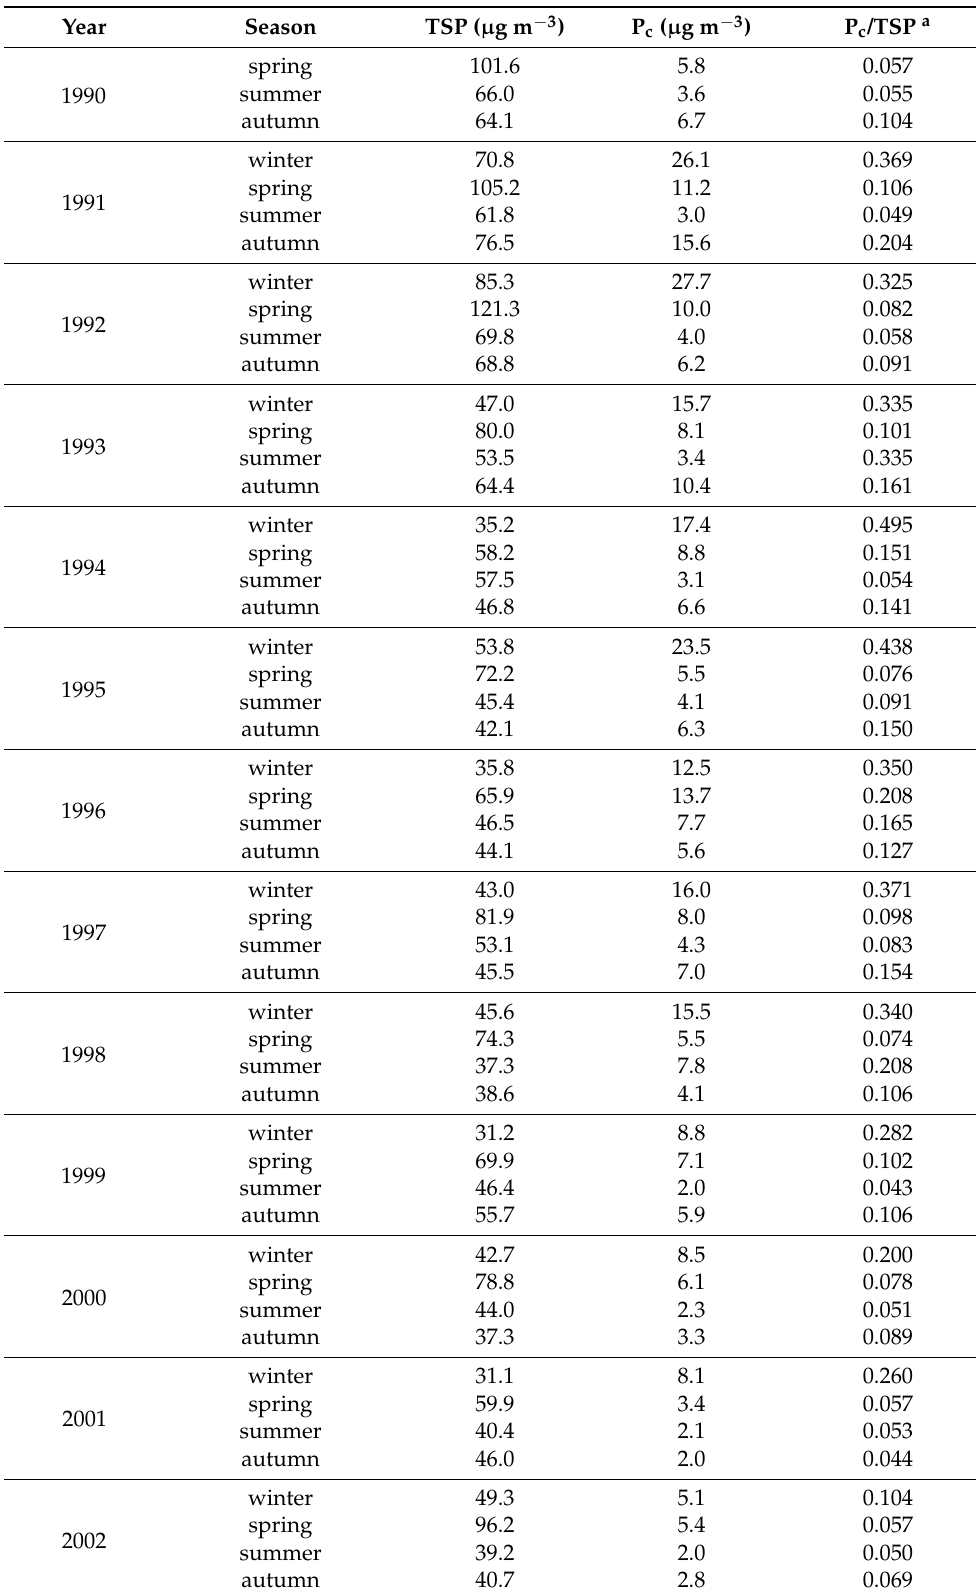
Table 1. Atmospheric concentrations of TSP and P c in Sapporo